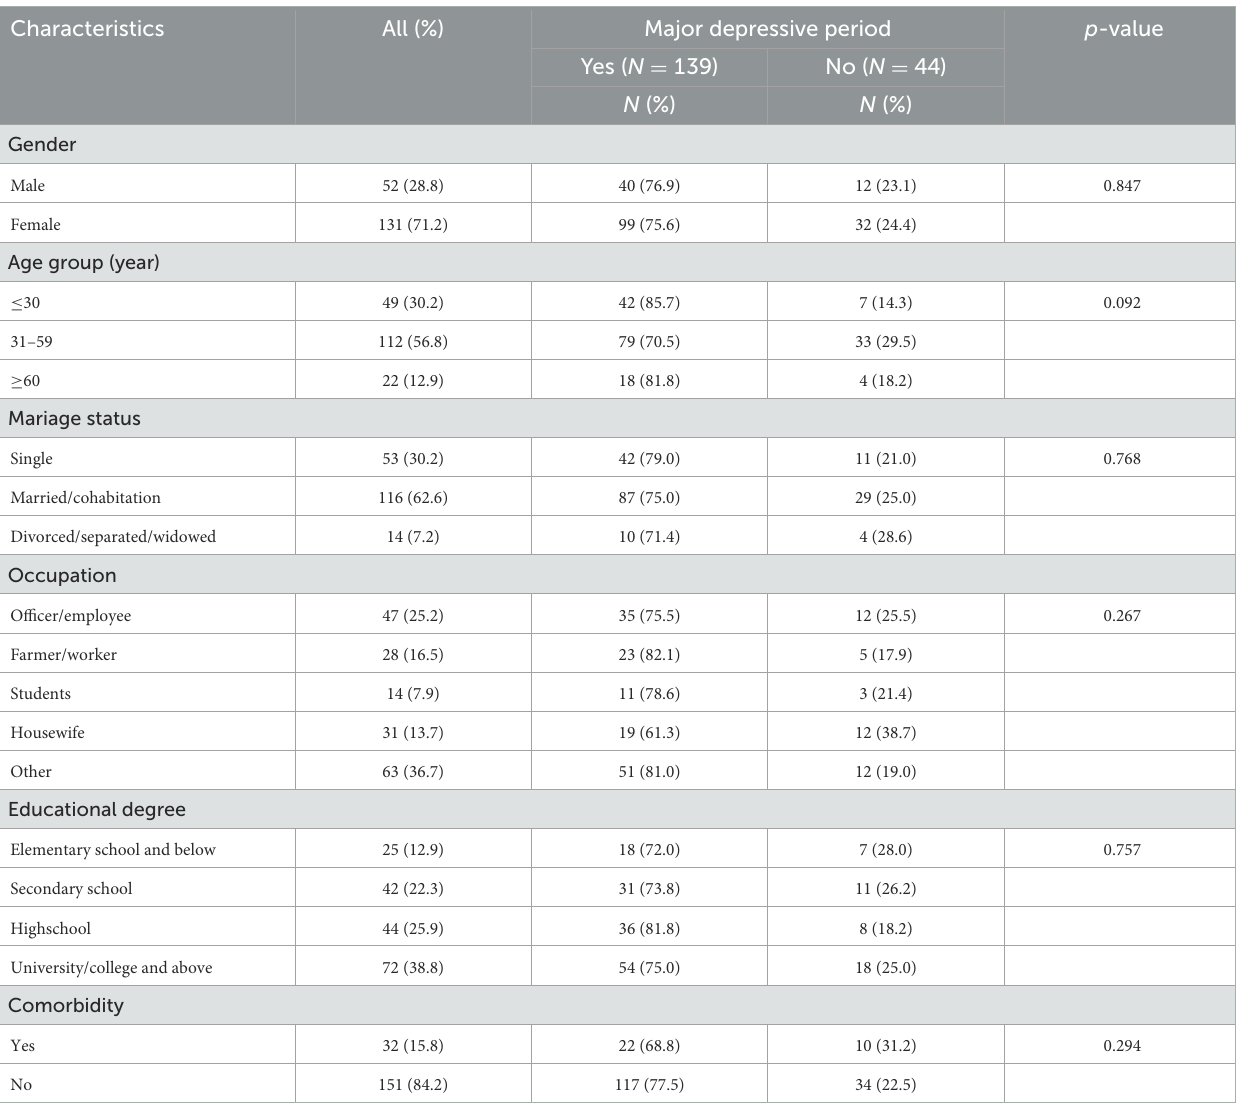
TABLE 1 Demographic characteristics of study participants ( N =